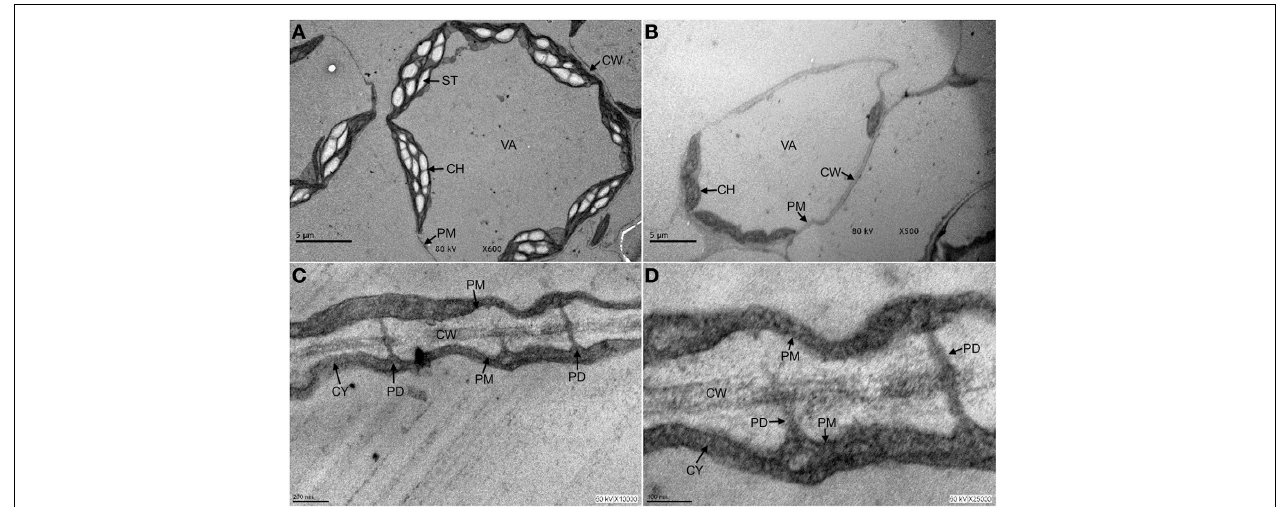
FIGURE 1 | Plasmodesmata are structures that persist under autophagy conditions. Three-week old Arabidopsis seedlings were exposed to 10 μ M fumonisin B1 for 4 days in order to induce programmed cell death in the form of autophagy. After this time, leaf tissue was fixed and processed for transmission electron microscopy analysis as described in Saucedo-García et al. (2011a,b). (A) Control leaves from seedlings exposed to H2O. (B–D) Leaves from seedlings exposed to fumonisin B1 are shown at the indicated magnification. In (A) , it is observed that under control treatment, cells show a rounded shape with typically elongated chloroplasts and starch bodies, some